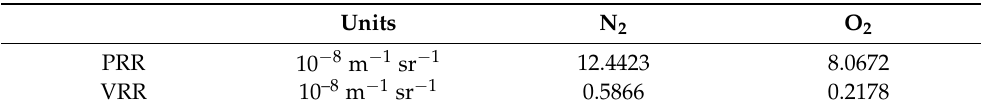
Figure 1. Pure rotational and vibro-rotational Raman backscatter spectra intensities calculated for diatomic Nitrogen (N 2 ) and diatomic Oxygen (O 2 ). Excitation wavelength: 354.76 nm. The spectra shown correspond to a 300 K temperature and to a 1013 hPa pressure. Table 1. Calculated intensities of the Raman backscatter spectra of Pure rotational Raman (PRR) and Vibro-rotational Raman (VRR) for diatomic nitrogen (N 2 ) and diatomic oxygen (O 2